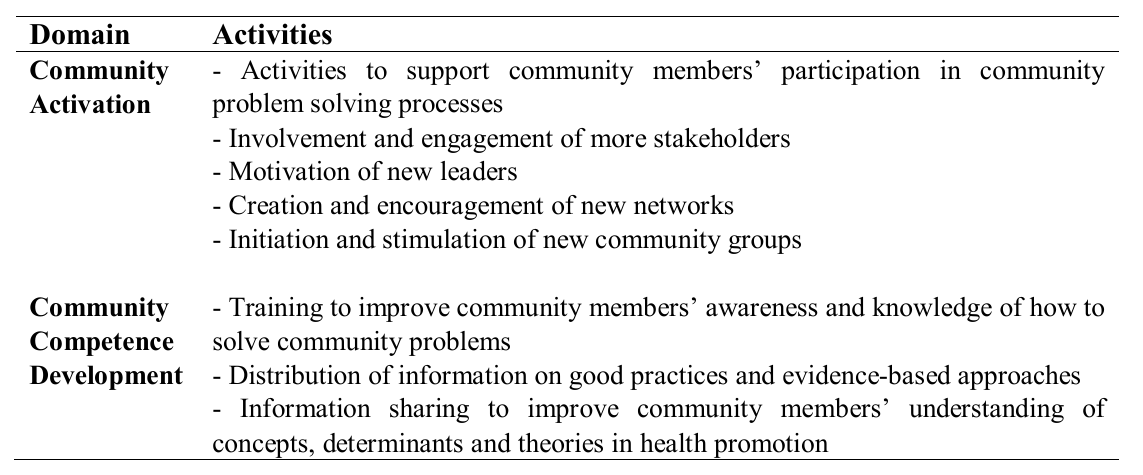
Table 3. Organizational domains of community empowerment and corresponding activities identified by Rapla community